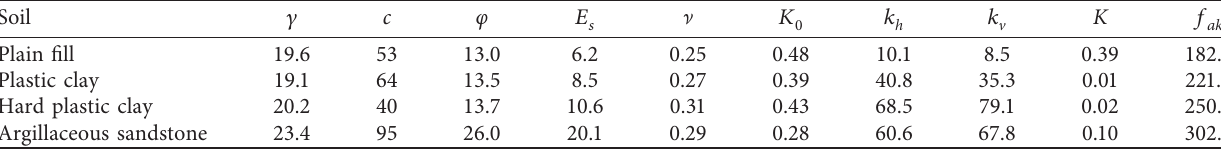
Table 1: Basic parameters of the soil on the site of the considered case